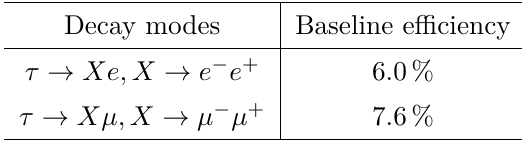
Table 3 . Baseline efficiencies reproduced from ref.